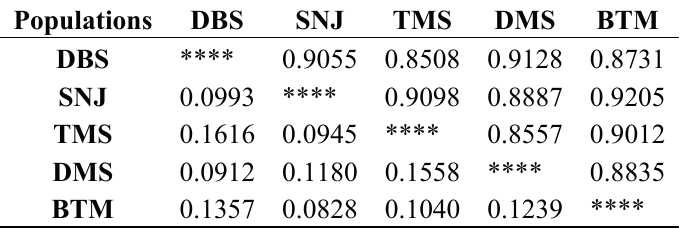
Table 3. Nei’s genetic identity (above diagonal) and genetic distance (below diagonal) among the C. japonicum populations.